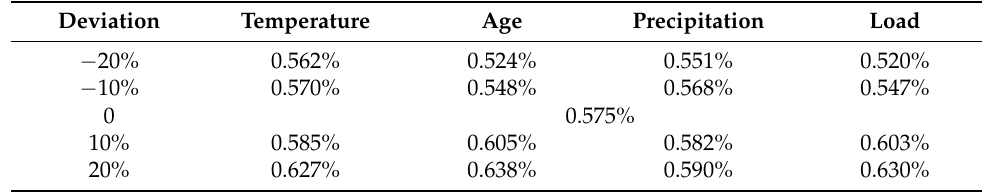
Table 5. LOLP on different physical conditions.